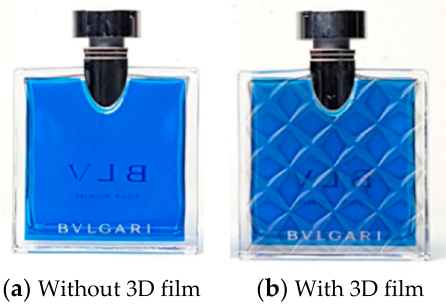
Figure 3. Commercial good without and with 3D film.